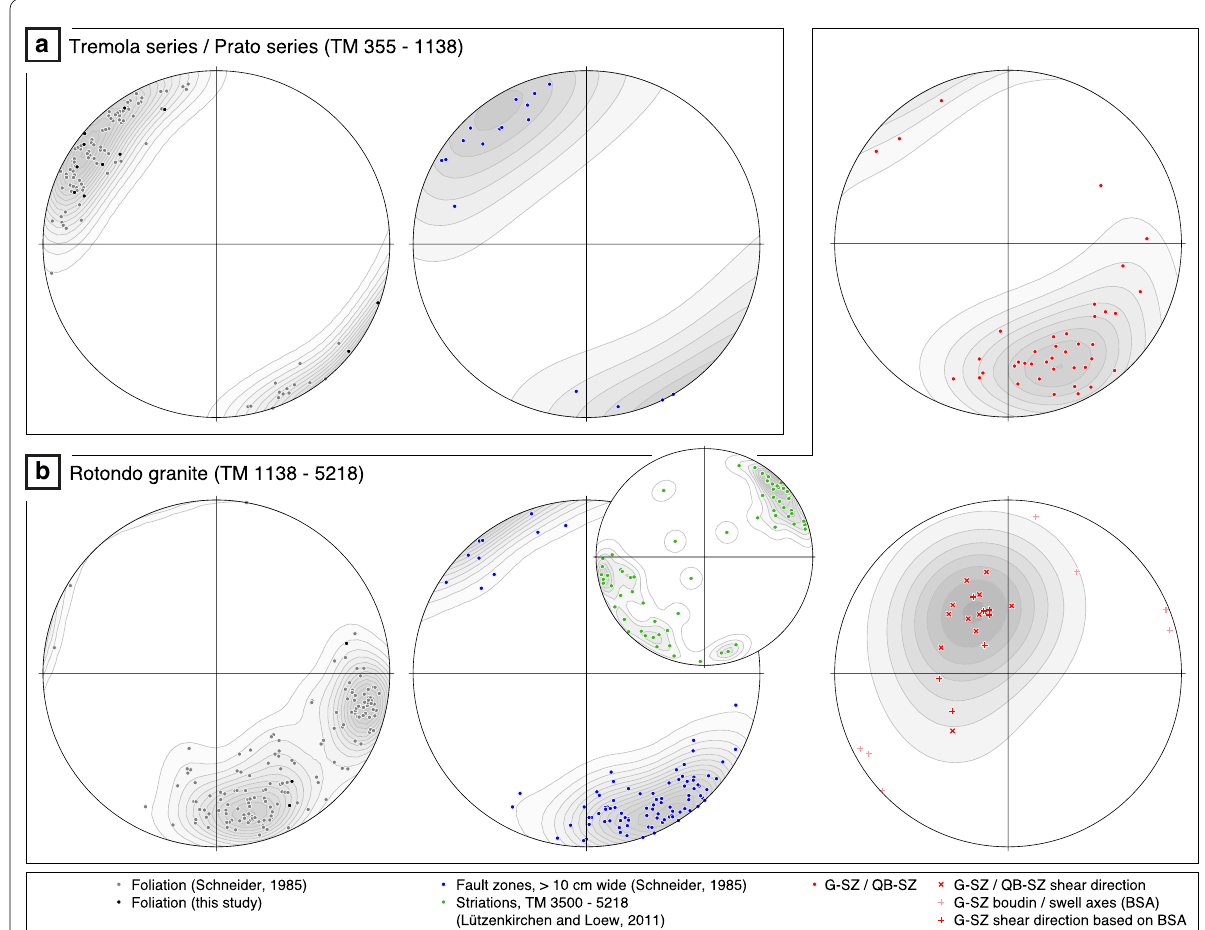
Fig. 4 Lower hemisphere equal area projections. Data of present study, Lützenkirchen and Loew (2011), and Schneider (1985) are shown. Legend in lower part of figure applies to both sub-figures. The sectors along the Bedretto tunnel, which correspond to the two sub-figures are indicated in Fig. 3b. Stereonet 10.4.2 was used to create plots (Cardozo and Allmendinger, 2013), contour lines according to Kamb method (Kamb, 1959). a Structural data of Tremola and Prato series: poles of foliation and fault zones ( > 10 cm wide). Note that the part of the Tremola series affected by Quaternary gravitationally driven re-orientation of the structures (‘toppling zone’ between TM 0 and 355) is not shown. b Structural data of Rotondo granite: poles of foliation, fault zones ( > 10 cm wide), G-SZ, and QB-SZ, and linear structural elements of fault zones (defined by striations), G-SZ, and QB-SZ. Contour lines are plotted for the shear directions in shear zones (G-SZ and QB-SZ), which are defined by stretched and recrystallized biotite or the intersection between the foliation plane and the plane normal to the boudin/swell axes